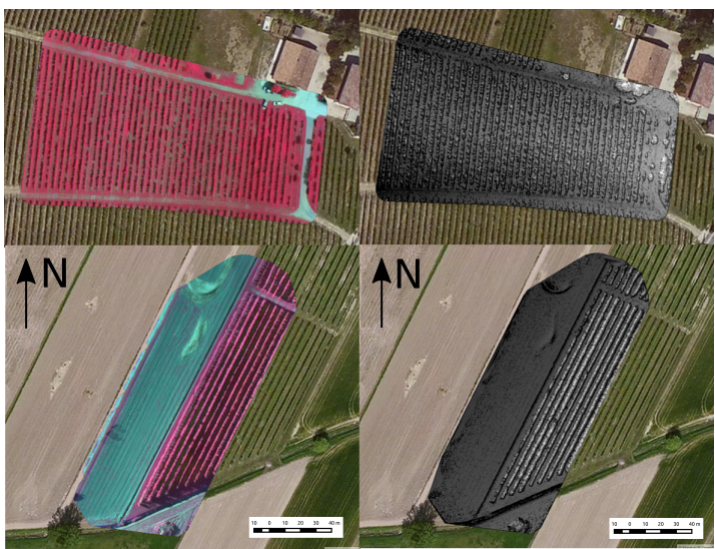
Figure 4. ( top left ) Study area 1, derived orthophoto of vineyard area with false color. ( top right ) Derived DSM (black represents low height) of about 4000 × 2500 pixels. ( bottom left ) Study area 2, derived orthophoto of plant fruit area with false color. ( bottom right ) Derived DSM (black represents low height) of about 3500 × 4500 pixels. The scale bar represents 40 m along level